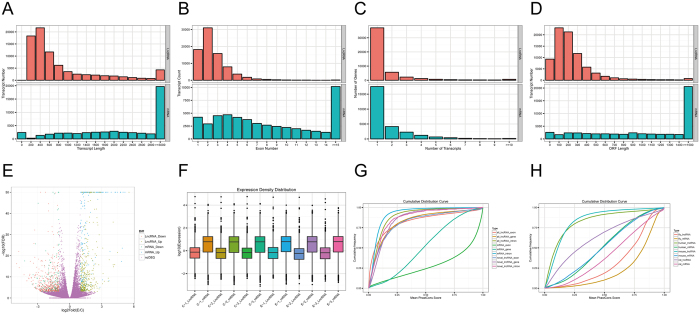
LncRNA genomic features in primary hBMECs.(A) Transcript lengths of 25,257 lncRNAs (red) and 18,005 mRNAs (green). (B) Exon numbers of lncRNAs and mRNAs. (C) Transcript numbers of lncRNAs and mRNAs. (D) Open reading frame length distribution of lncRNAs and mRNAs. (E) Volcano plots of the overall distribution of lncRNAs and mRNAs. (F) Box plots showing the expression density distribution of lncRNAs and mRNAs in each sample. (G) The cumulative distributions of median PhastCons score for various kinds of transcript. (H) Conservation score comparison for lncRNAs and mRNAs in human, mouse, rat and fruit fly.